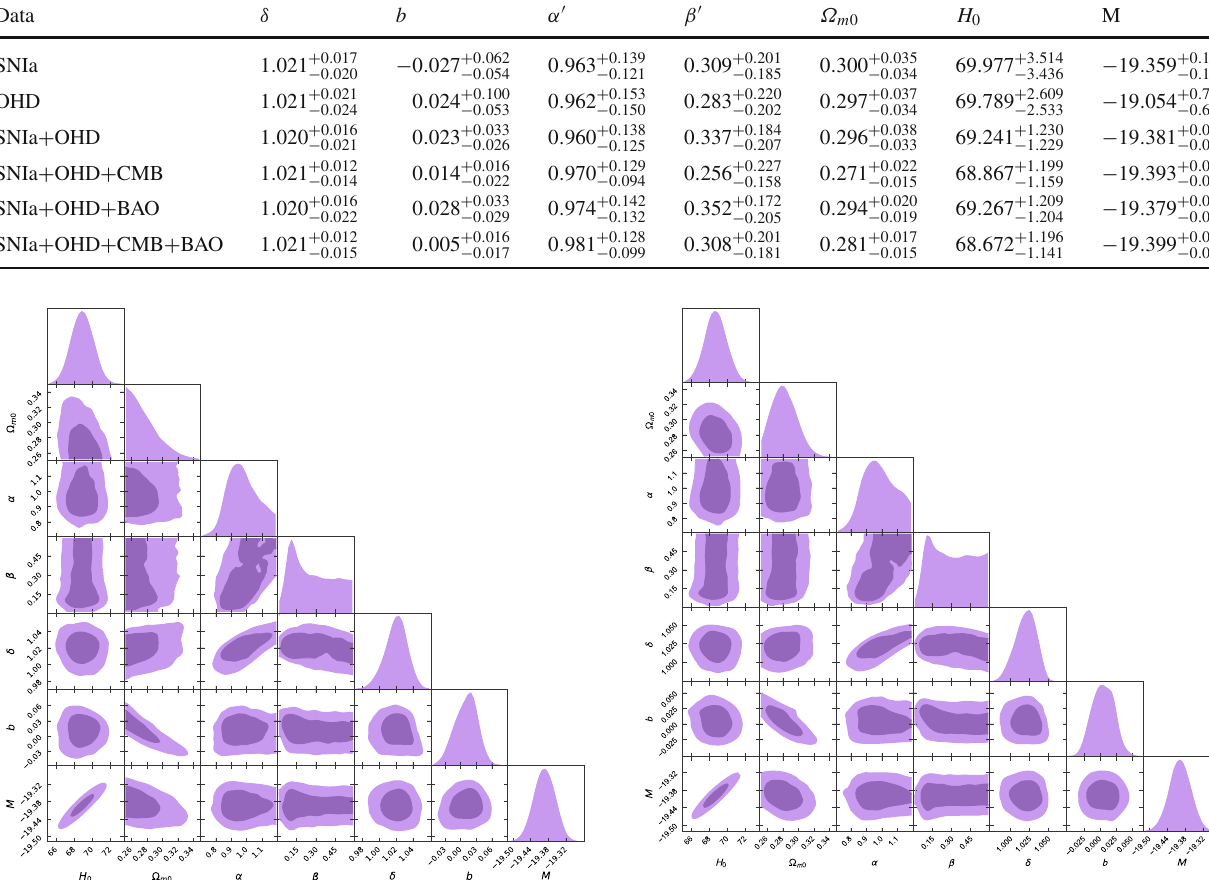
Fig. 1 The two dimensional posterior contours with 68% and 95% confidence limits and one dimensional posterior distribution (using pygtc open python package [108]) from the ( a ) SNIa+OHD+CMB and ( b ) SNIa+OHD+CMB+BAO datasets for the free parameters of THDE